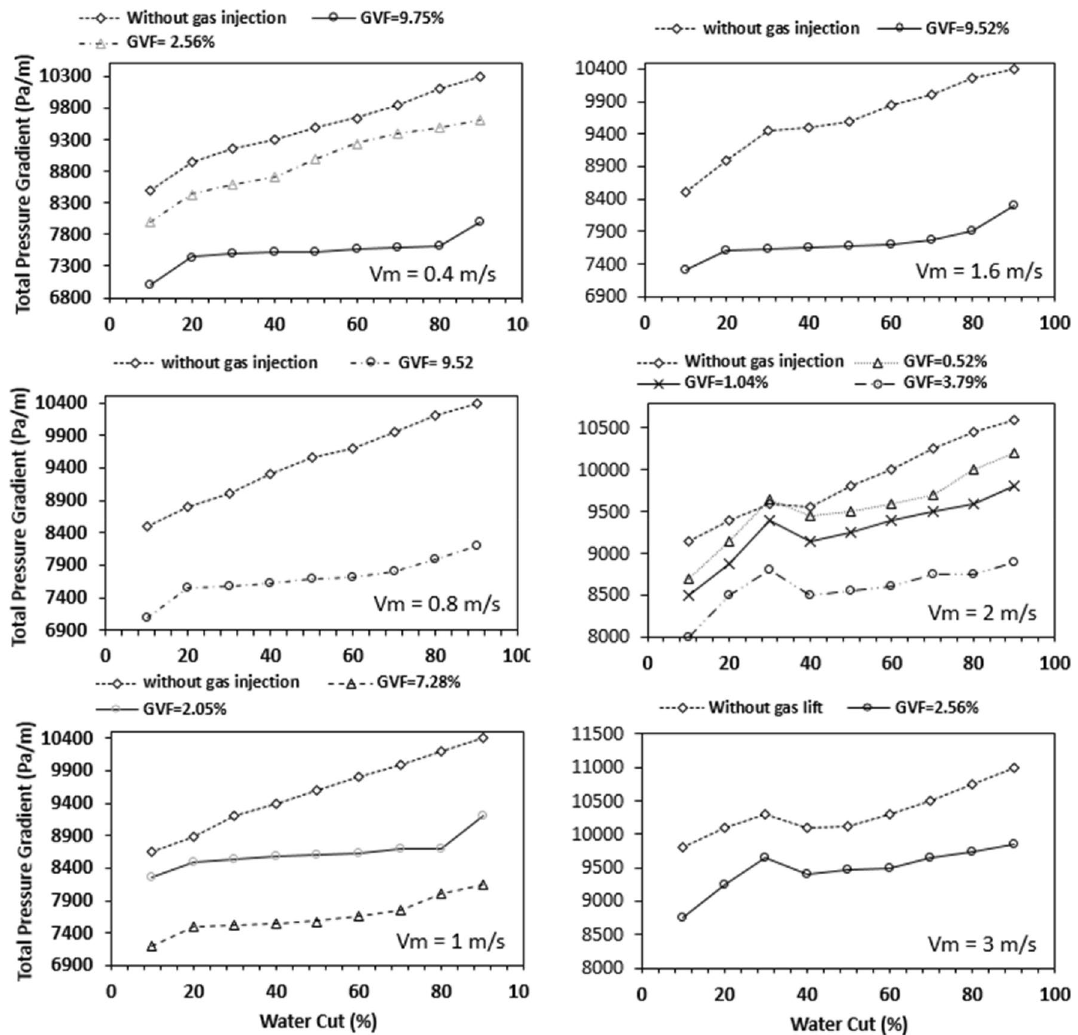
Fig. 4 Total pressure gradient as function of water fraction for an oil–water flow with gas injection at different mixture